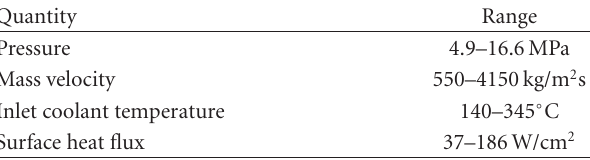
Table 1: Range of NUPEC PWR test facility operating